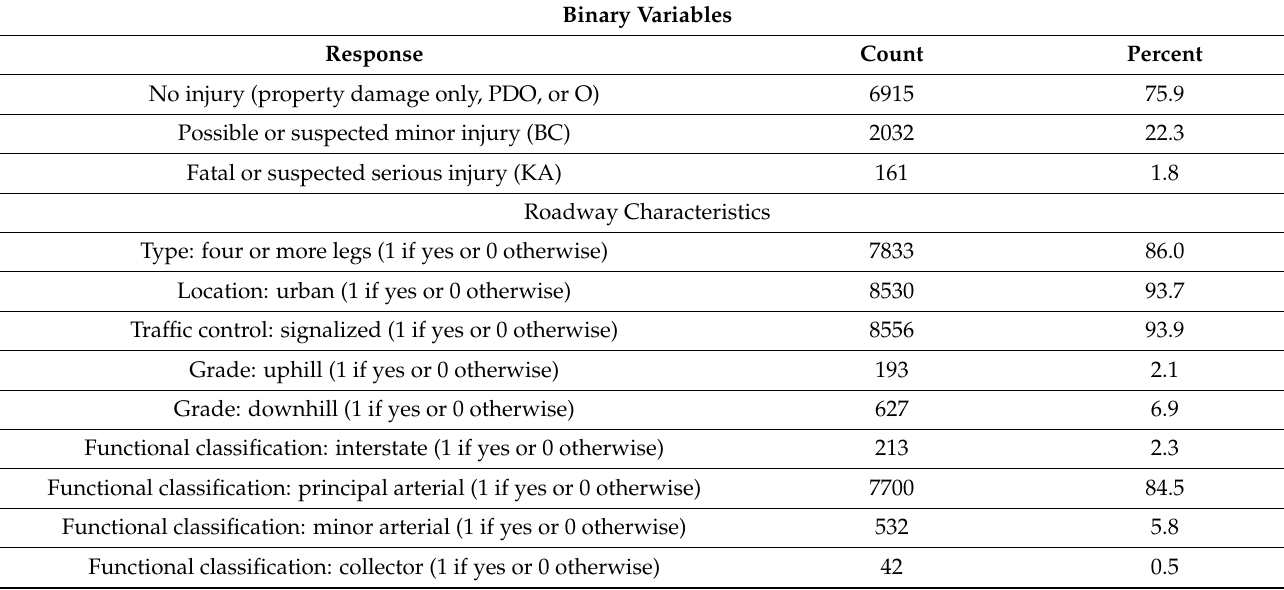
Table 1. Data’s descriptive